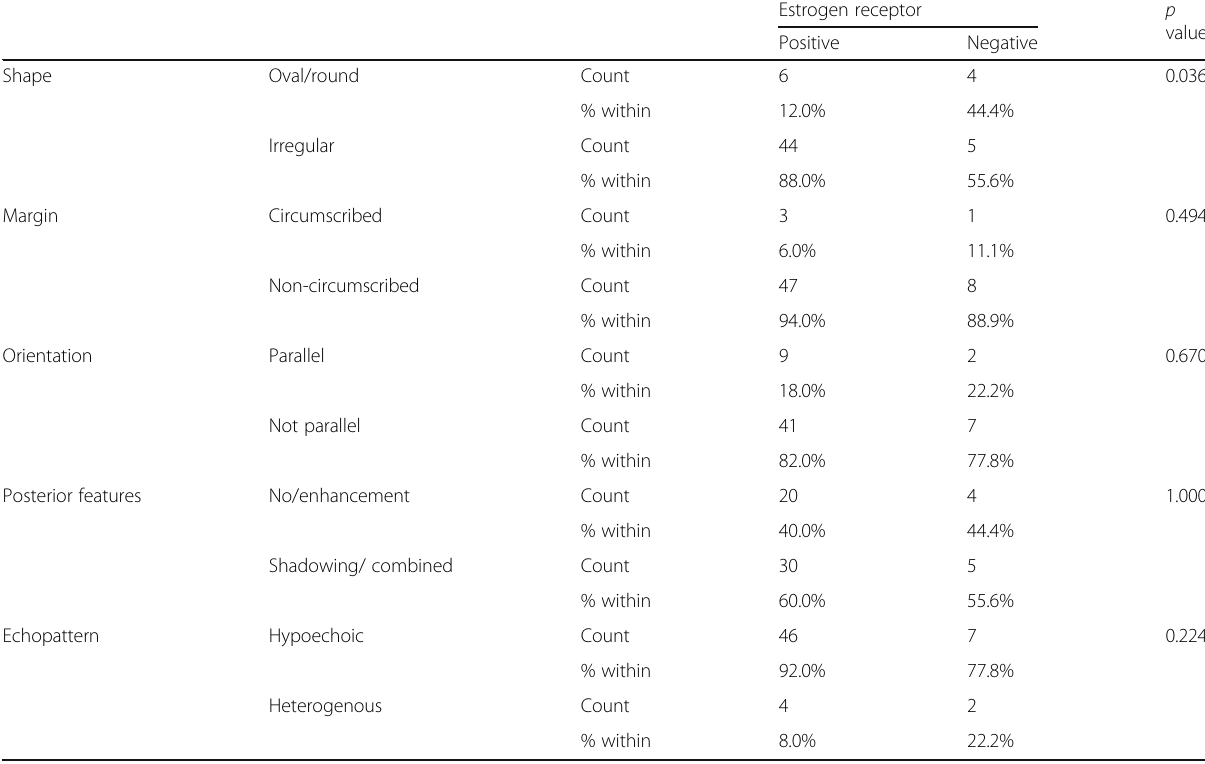
Table 4 Association between status of estrogen receptors and ultrasound findings of breast